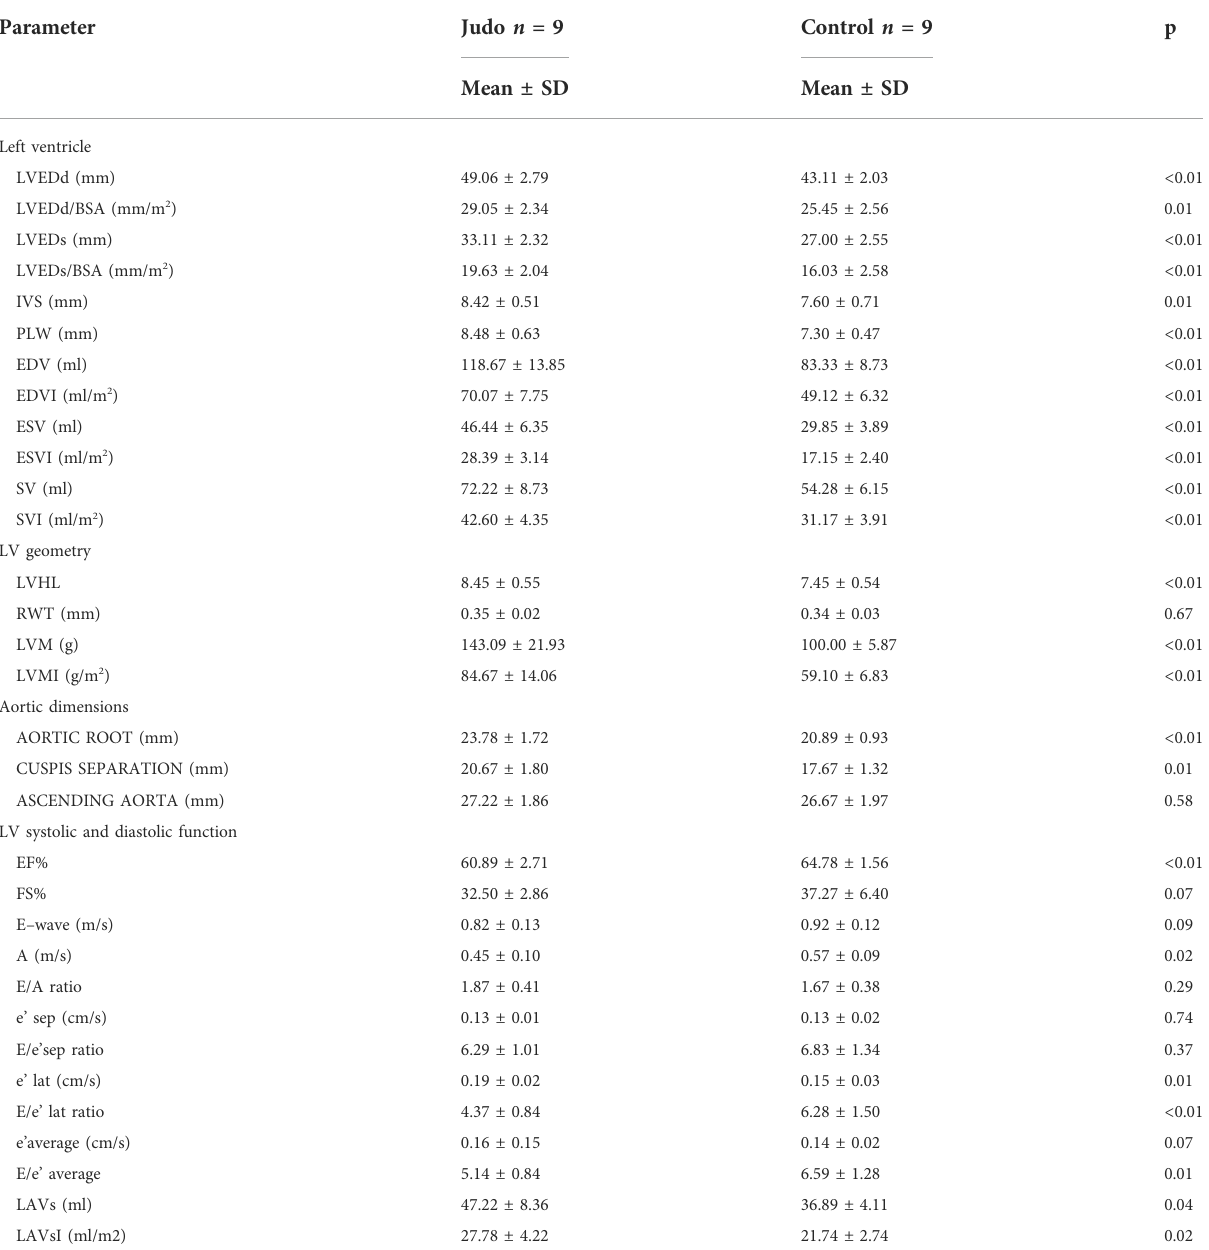
TABLE 1 Echocardiographic characteristics of the study